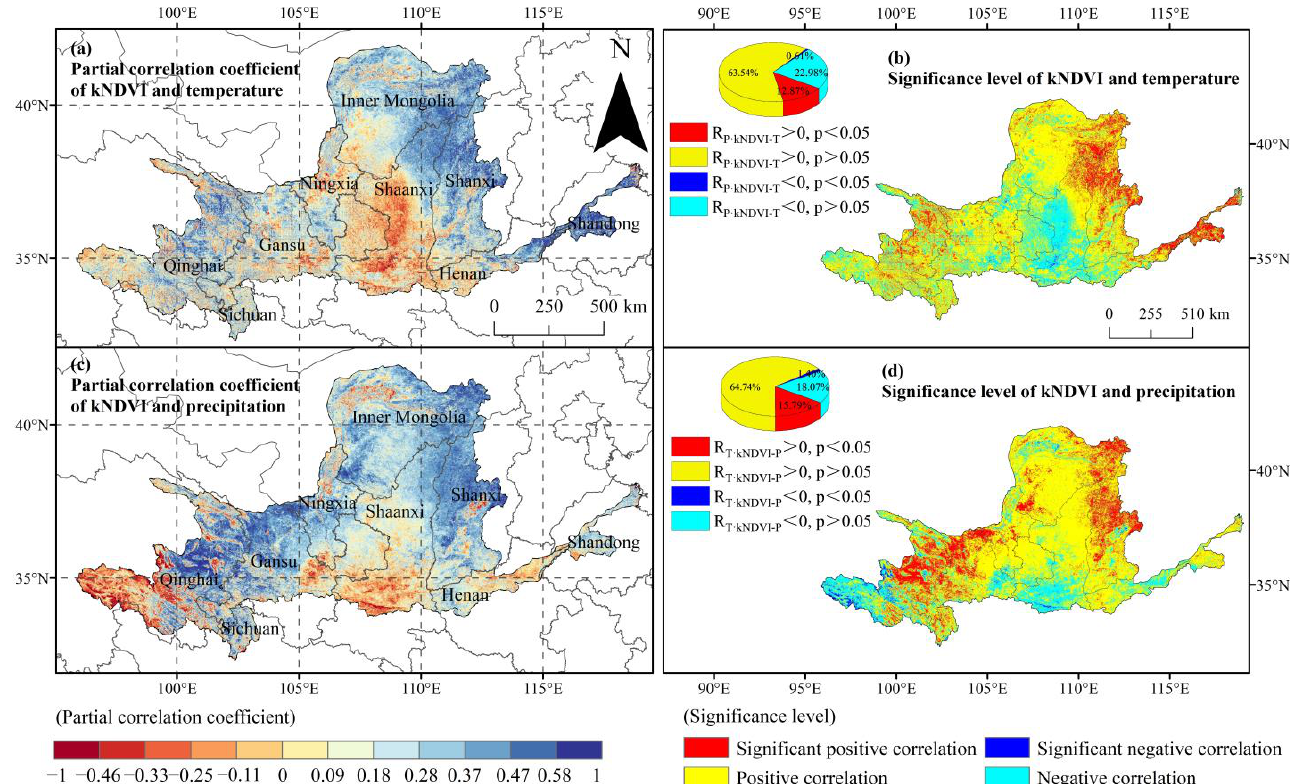
Figure 8. Spatial distribution of partial correlation coefficient and significance level between kNDVI and climatic factors: ( a ) partial correlation coefficient between kNDVI and temperature, ( b ) significance degree of partial correlation coefficient between kNDVI and temperature, ( c ) partial correlation coefficient between kNDVI and precipitation, and ( d ) significance degree of partial correlation coefficient between kNDVI and precipitation. R P·kNDVI-T refers to the partial correlation coefficient between kNDVI and temperature; R T·kNDVI-P refers to the partial correlation coefficient between kNDVI and precipitation.